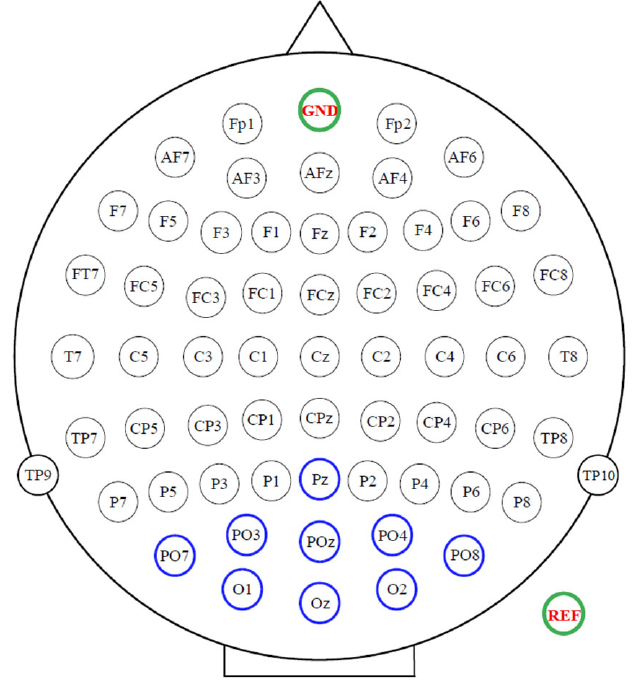
Figure 4. Placement of electrodes. The blue circles are the placements of the sampling electrode. The reference electrode is placed on the green circle behind the right ear, and the ground electrode is placed on the forehead.